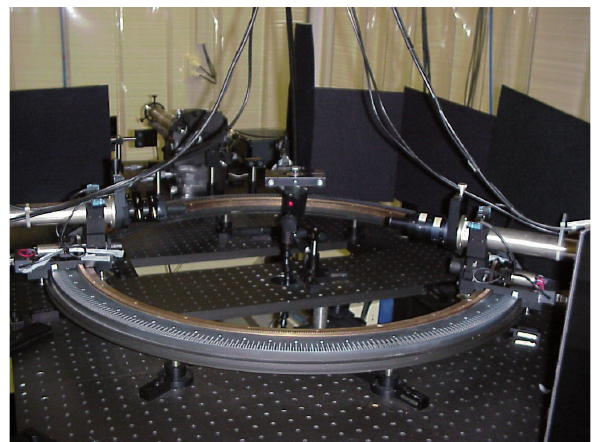
Fig. 1: The Amsterdam light scattering setup.